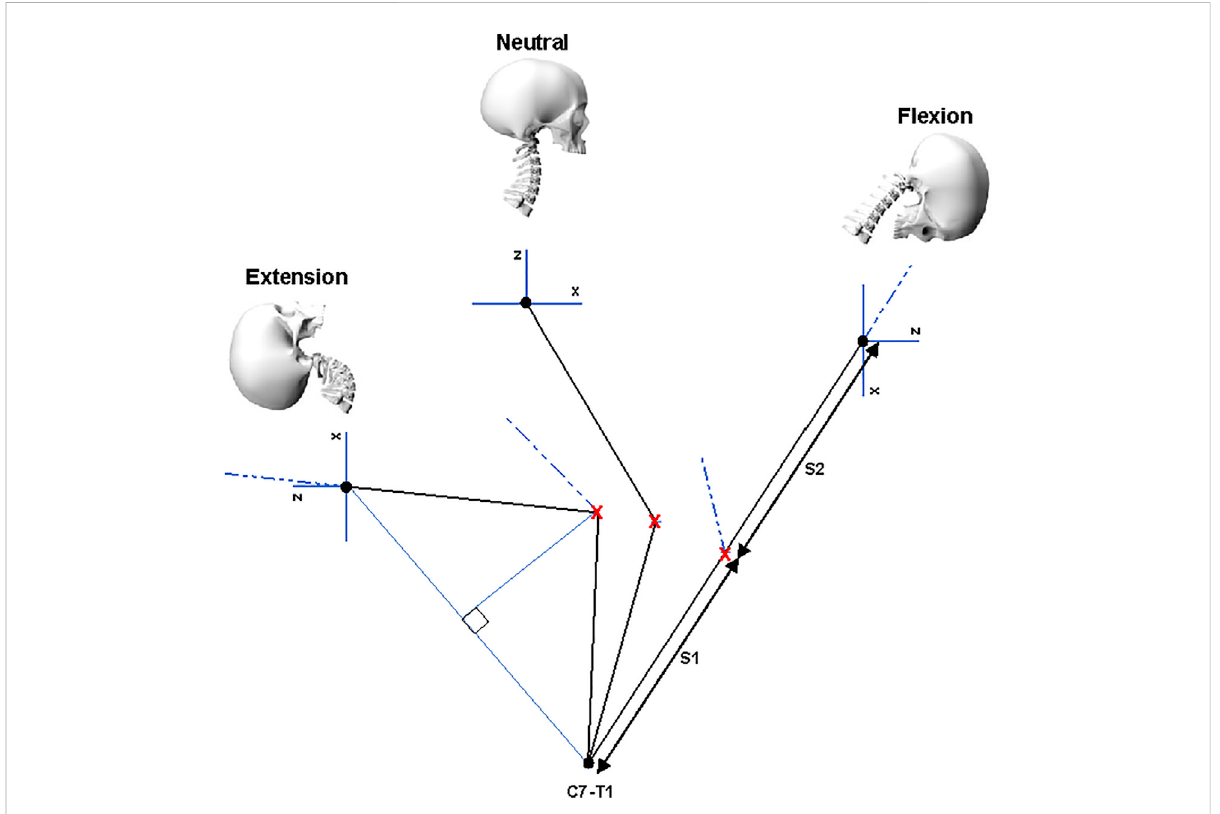
Locationofthethirdjointcentreasde fi nedbytheanteriorinterceptoftwocircleswithequal radii,equidistancefromtheC0-C1andC7-T1ICR locations in the mid-sagittal plane. The resulting orientation of the Frankfort plane in the extension and fl exion bending modes is also